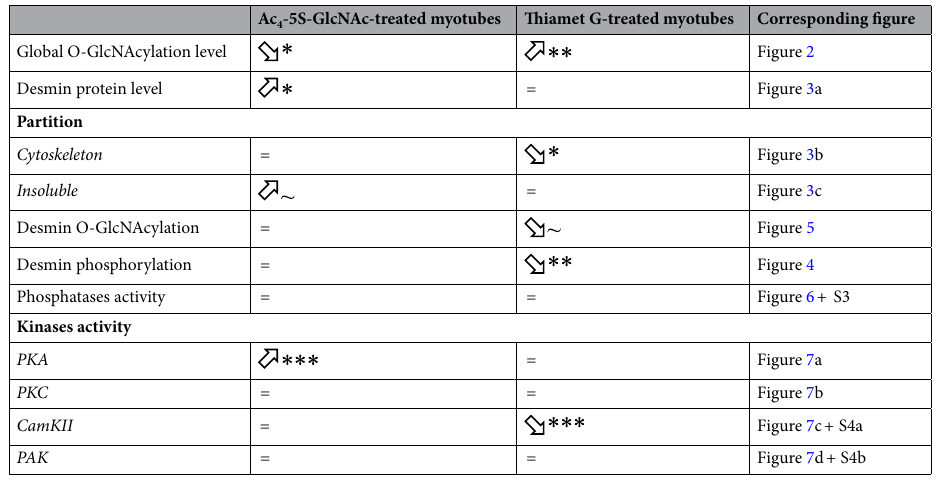
Table 1. Recapitulative table of desmin behaviour in Ac 4 -5S-GlcNAc- and Thiamet G-treated myotubes, leading to a decrease and increase of global O-GlcNAcylation level, respectively. In this table the changes of desmin protein level and partition of desmin towards cytoskeleton and insoluble materials were represented. The variations of desmin O-GlcNAcylation and phosphorylation were also considered, as well as the kinases and phosphatases activities. Variations were compared with control myotubes. Significance levels were indicated by *p < 0.05, **p < 0.01, ***p < 0.001, or ~ for 0.05 < p <